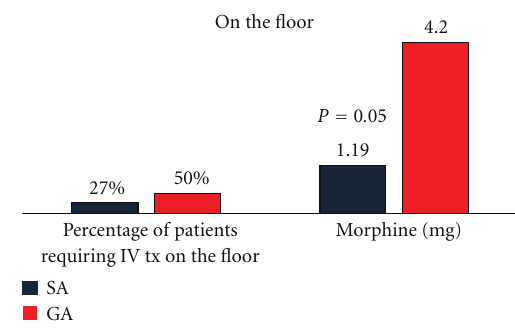
Figure 2: Percentage of patients requiring IV morphine and the dosage amount received by patients on the floor in the first 24 hours after surgery: spinal anesthesia in black versus general anesthesia in